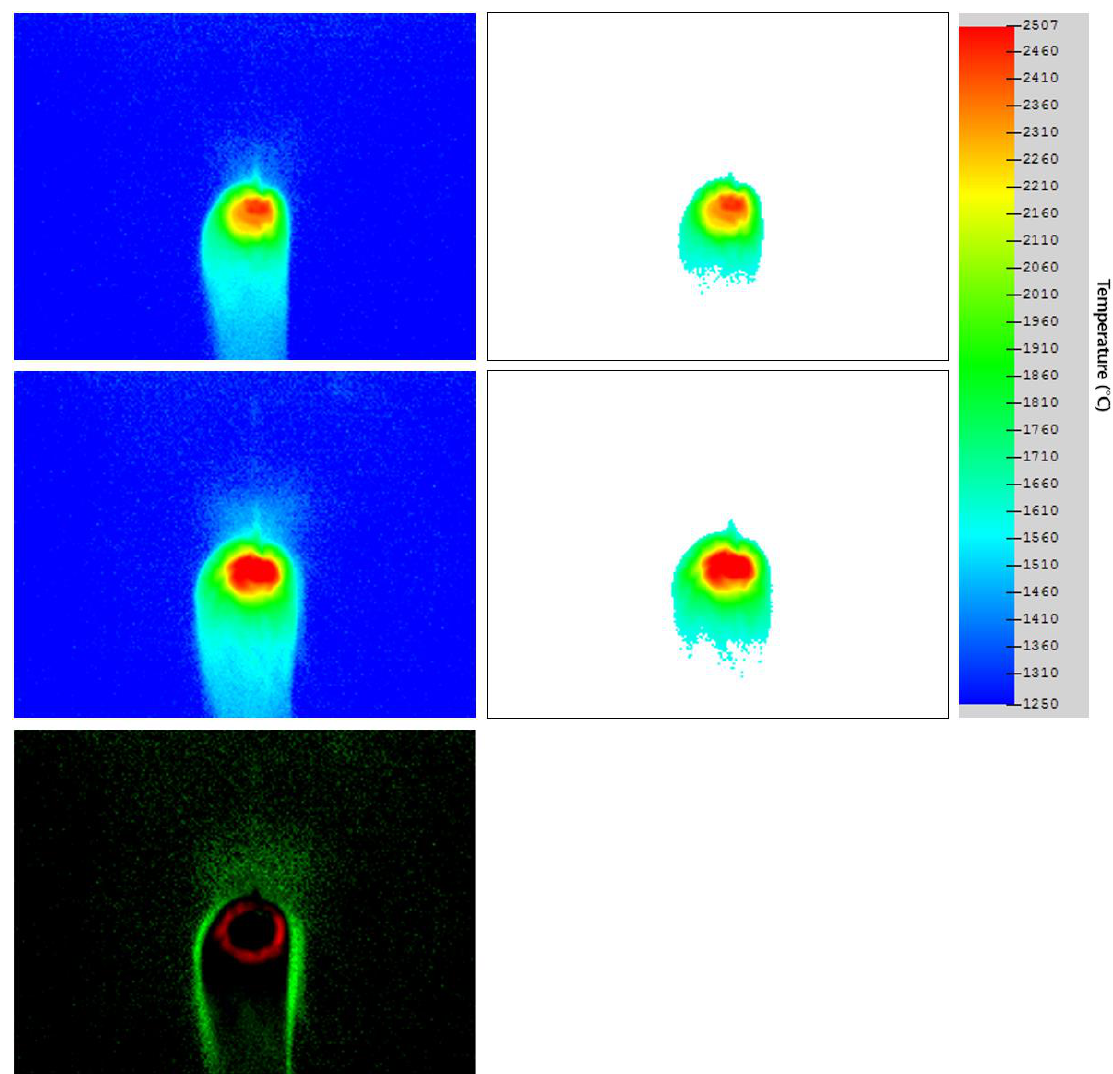
Figure 1. Thermal camera images of the melt pool: As-collected nominal size ( top left ), thresholded nominal size ( top right ), as-collected increased size ( middle left ), thresholded increased size ( middle right ), and as-collected comparison ( bottom left ).